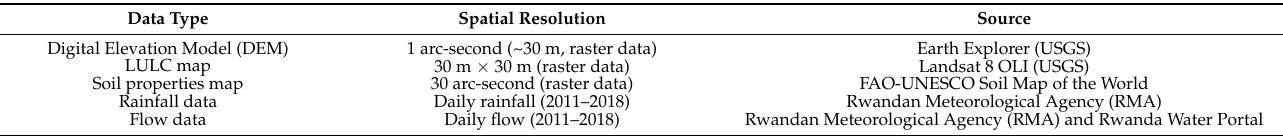
Table 1. The spatial databases for datasets included in this